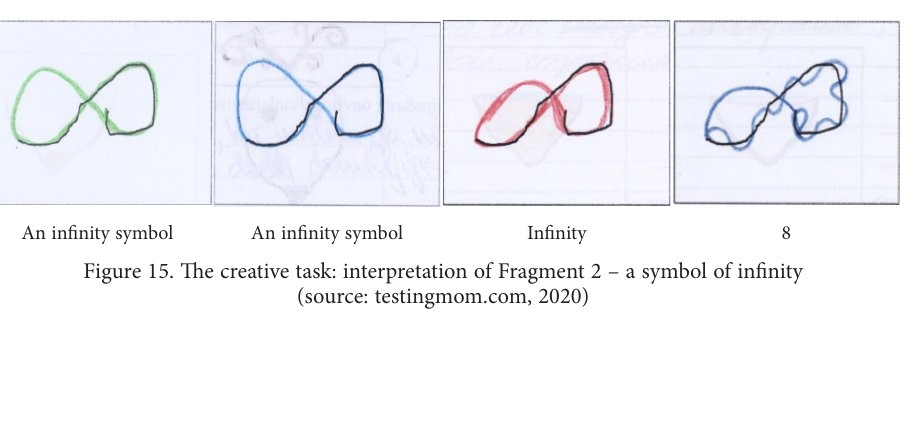
Figure 14. The creative task: interpretation of Fragment 2 – footwear (source: testingmom.com, 2020) Some participants (13.0%) associated the presented fragment with a symbol of infinity assigned to mathematical elements (Figure 15), although this symbol was used in just 6.1% of interpretations. The above-mentioned element was used in interpretations of one sixth of Belarusian participants, however such interpretation was not chosen by those from Lithuania and Estonia (Tables 3, 4).